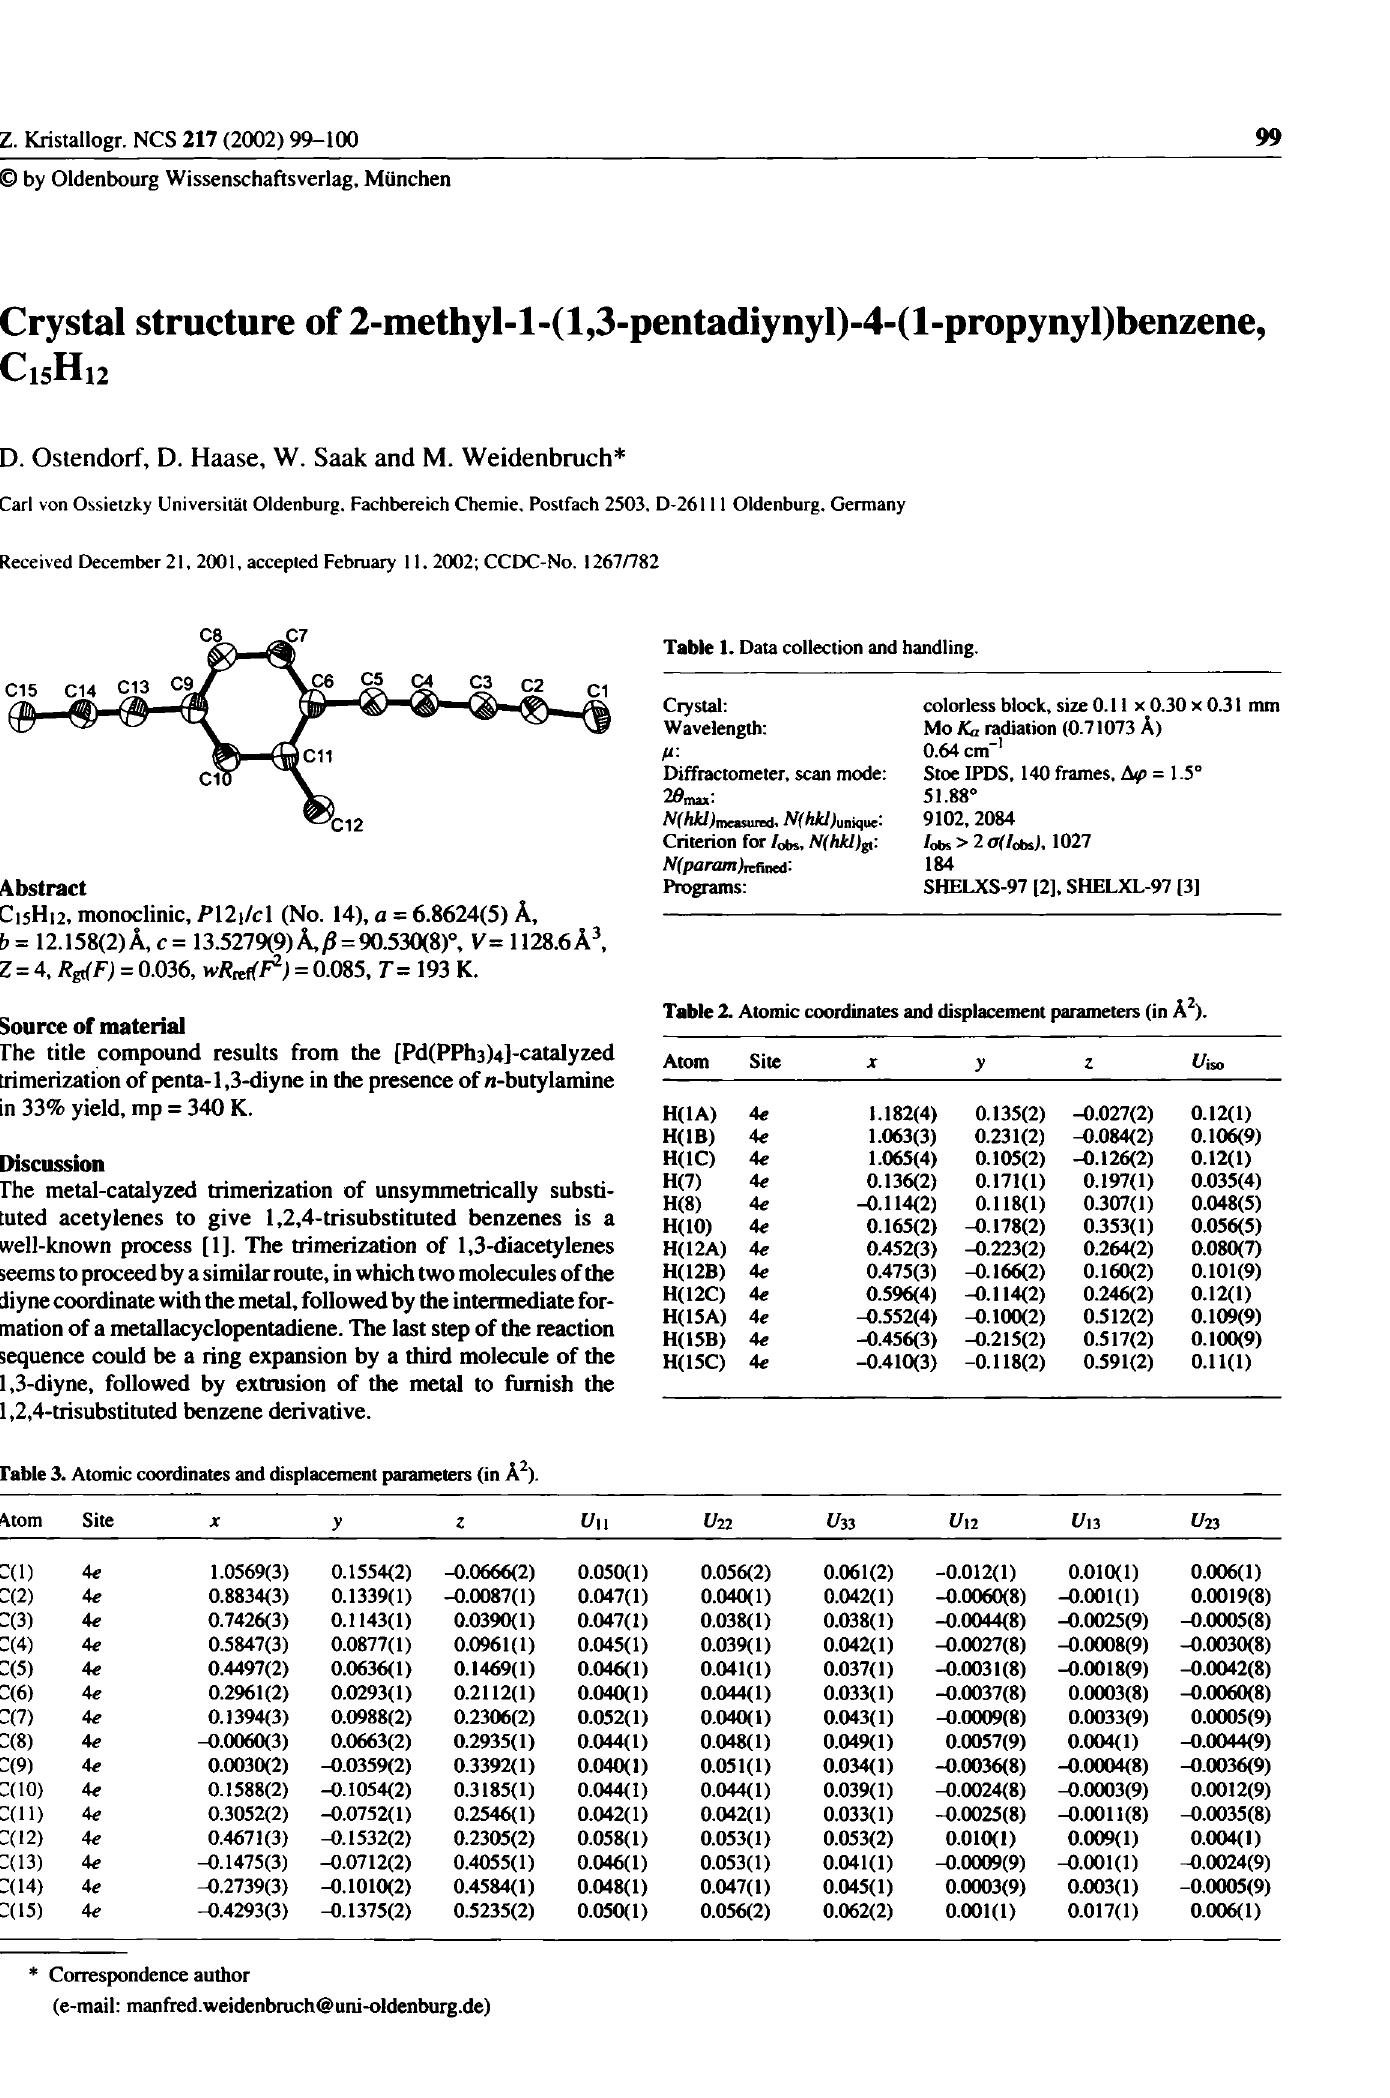
Table 1. Data collection and handling. Crystal: